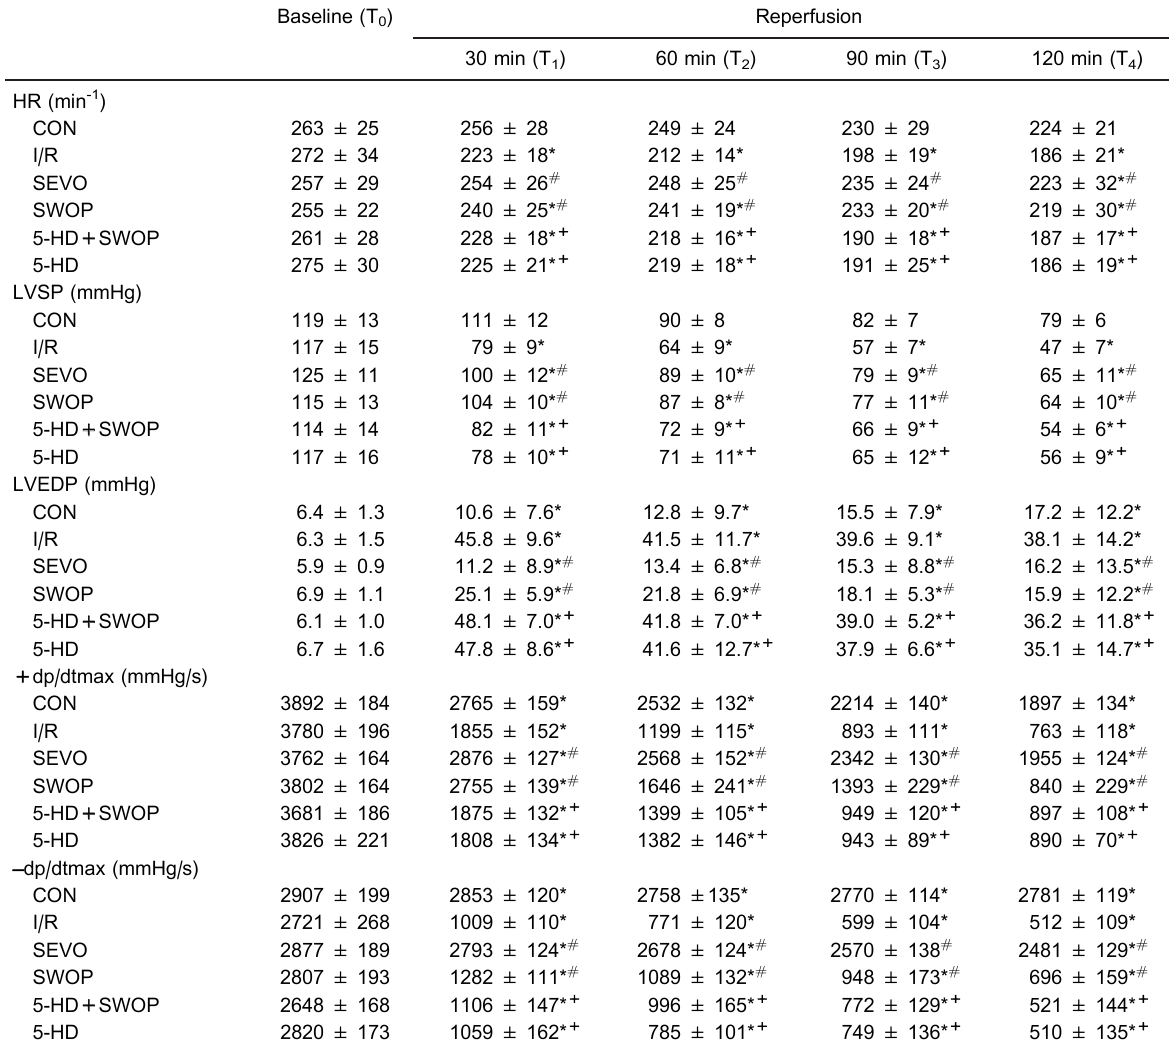
Table 1. Hemodynamic